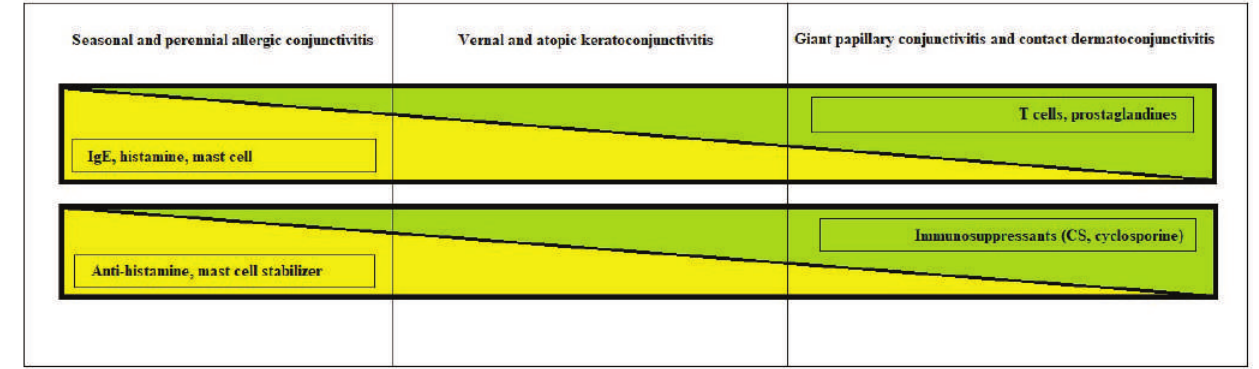
Figure 5. Spectrum of allergic conjunctivitis. CS, corticosteroid